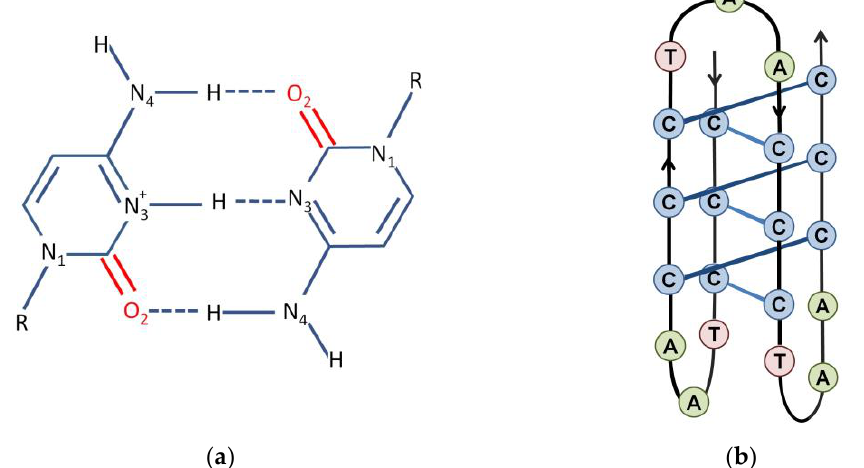
Figure 2. The structure of the i-motif. ( a ) A hemi-protonated cytosine-cytosine + base pair is the main building block of the i-motif. ( b ) Schematic representation of the complete three-dimensional structure of an i-motif.